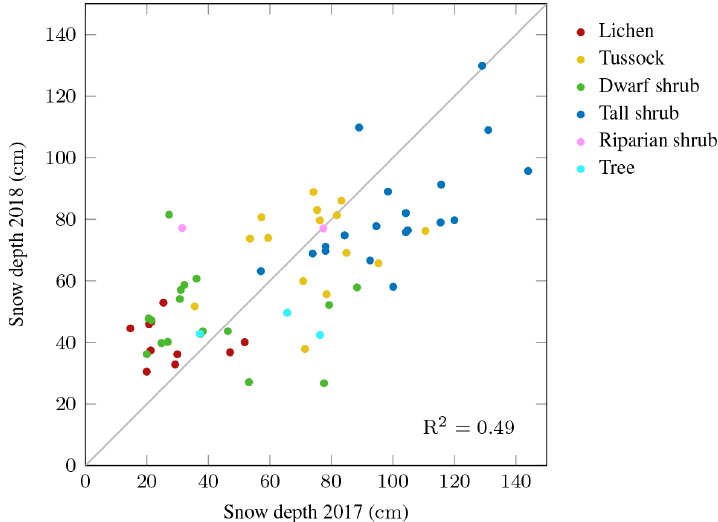
Figure B2. Snow depth measured at the end of April in 2017 and 2018 at approximately the same locations; the number indicates the Pearson’s correlation coefficient R 2 ; the grey line is the 1:1